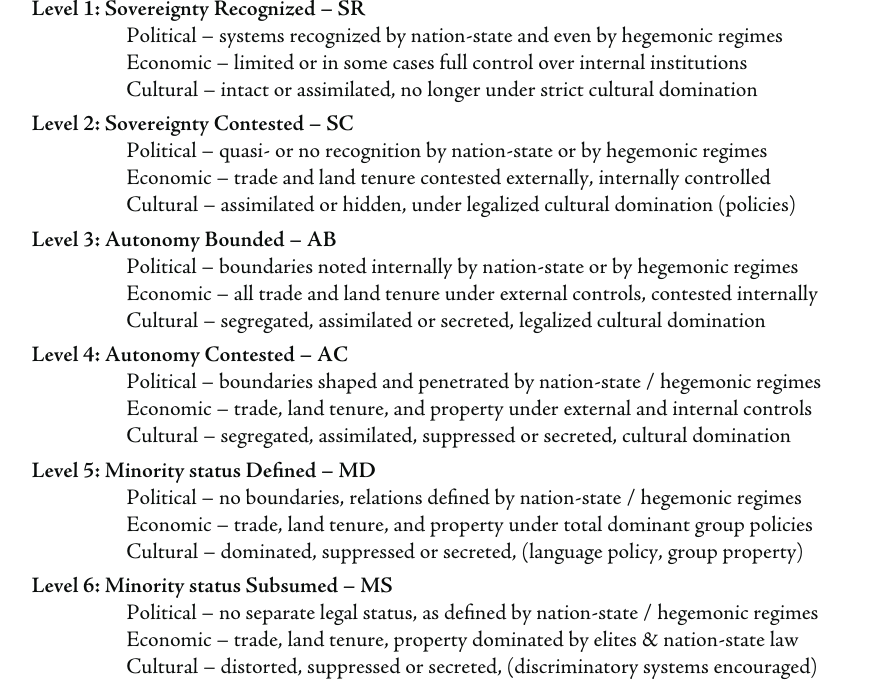
Table 1 – Levels and Types of Indigenous Survival within Hegemonic Nation- State Systems Level 1: Sovereignty Recognized –